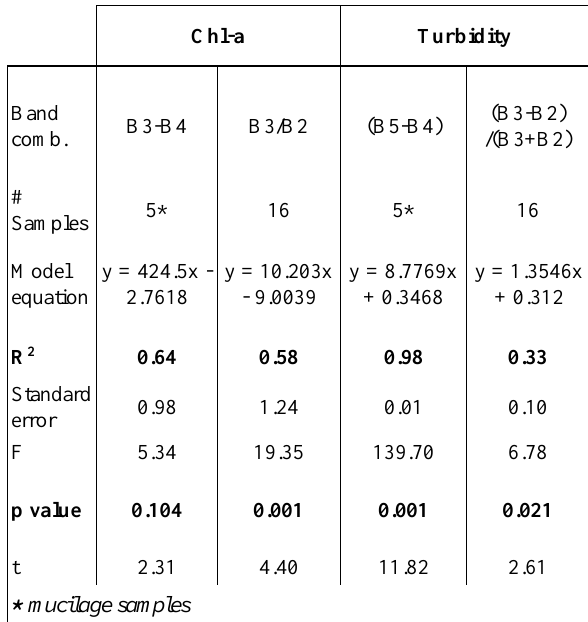
Figure 3. The best regression models for the estimation of the concentration of Chl-a with a) 5 mucilage samples, b) 16 samples.